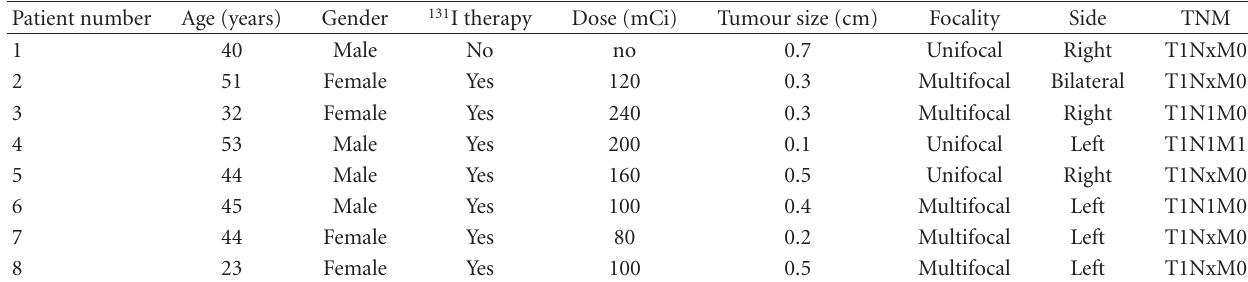
Table 1: Characteristics of the patients with local recurrence.